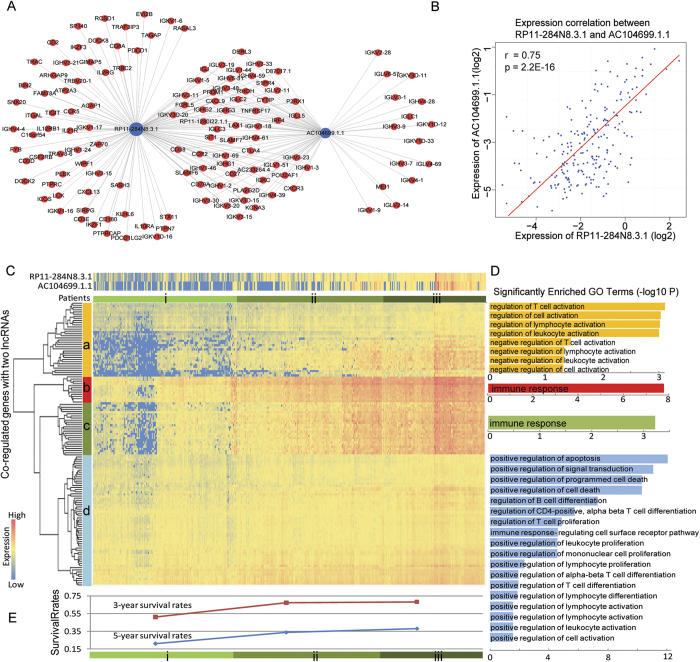
Comprehensive analysis of the function and expression of the two lncRNA subnetworks.(A) LncRNAs RP11-284N8.3.1 and AC104699.1.1 are one-step neighbors in the OVLMN and co-regulate 56 coding genes, most of which are immunoglobulin genes. (B) The expression of these two lncRNAs was highly correlative(Pearson Correlation: r = 0.75, p = 2.2E-16) (C) The expression profiles of the two lncRNAs and their regulatory coding genes. Based on a two-dimensional hierarchical cluster analysis, the coding genes were grouped into four classes across the three groups of patients. (D) A functional enrichment analysis for each group of genes indicates the immune- and cell cycle-associated roles of biological processes. (E) The corresponding 3-year and 5-year survival rates of each group of patients. The survival rates increased from patients in group i to those of group iii.